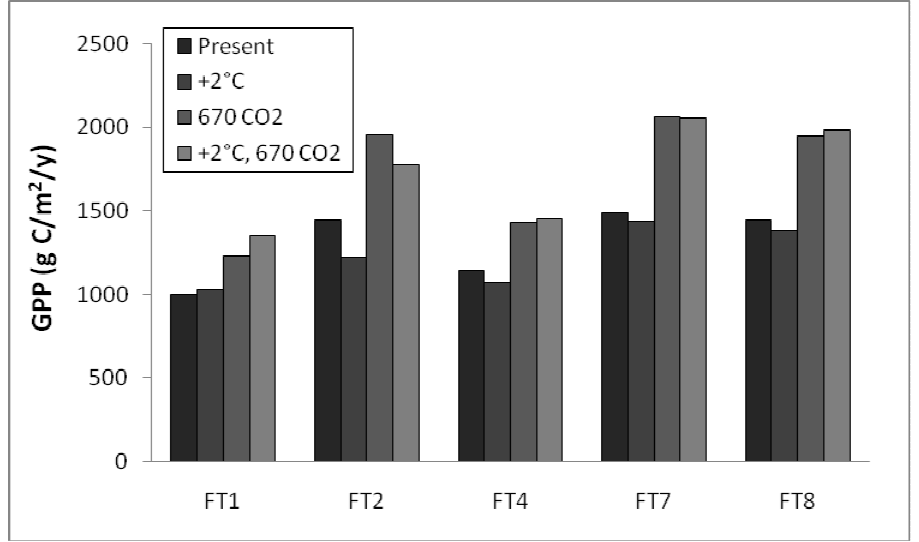
Figure 5. Annual GPP predicted by Modified C-Fix for the five Italian forest types in the environmental scenarios considered (present scenario, climate change, increased atmospheric CO and combination of the two 2